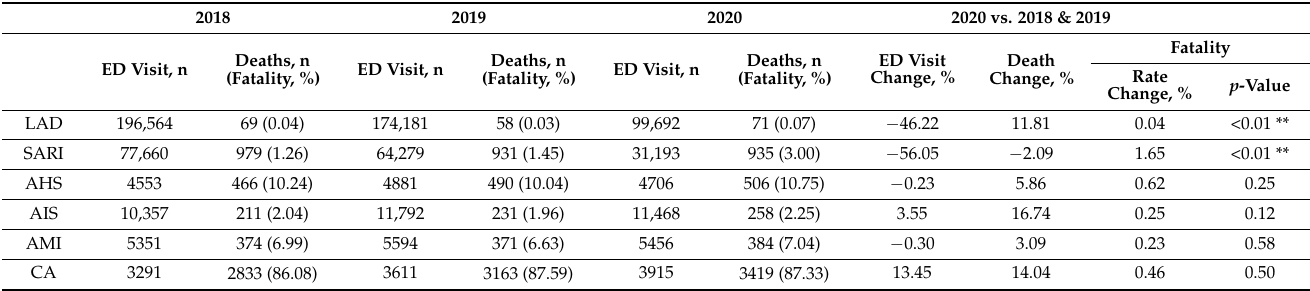
Table 1. Deaths within 7 days of an ED visit from 2018 to 2020 listed by diagnosis.